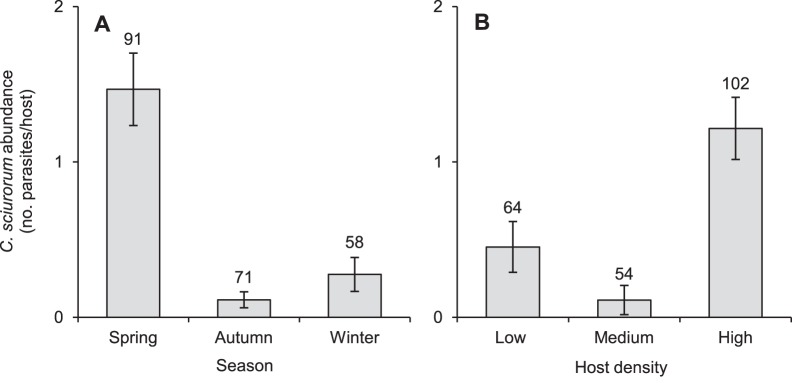
Variation of C. sciurorum abundance by season (A) and host density (B).Mean abundance of C. sciurorum (sample size above standard error bars) varied during different seasons (p<0.0001) and at different host densities (p<0.0001). Squirrels trapped in spring were more infested than in autumn and winter (both sequential Bonferroni adjusted p<0.0001) and animals living in high-density sites were more infested then those living in medium- and low-density populations (both adjusted p<0.008).